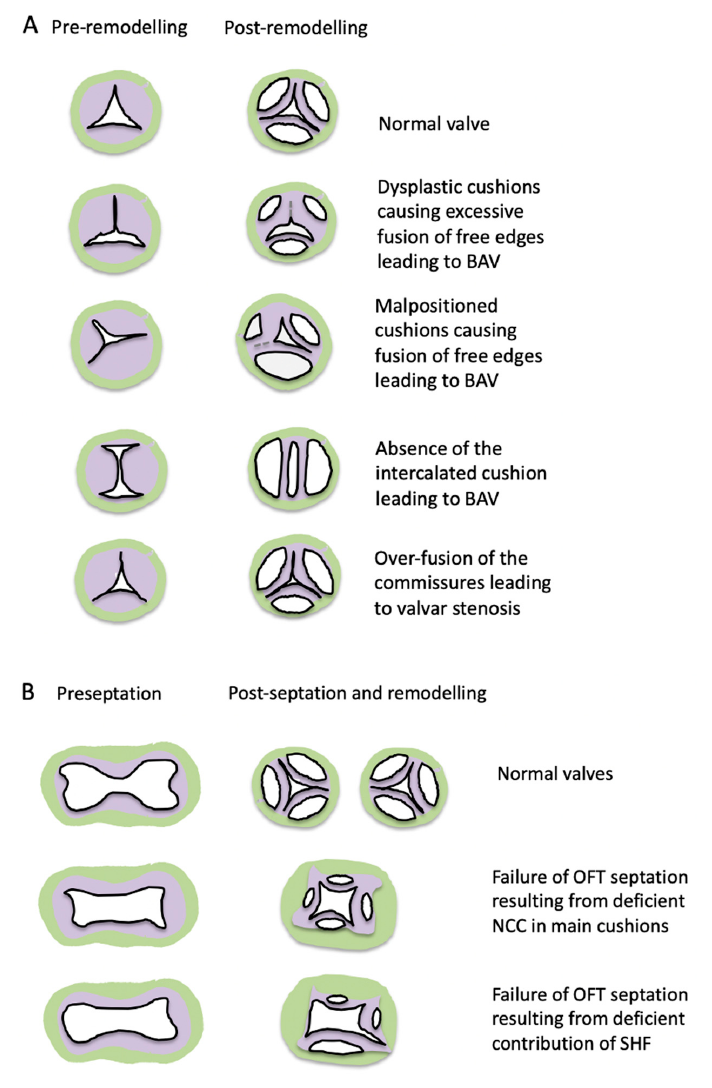
Figure 6. Possible mechanisms underlying THE bicuspid aortic valve BAV. ( A ) Cartoon illustrating several possible mechanisms underlying BAV in the situation of outflow tract septation. These can result in different numbers of sinuses and raphes and can occur early in development (as shown) or later in development as a consequence of pathological processes. Valvar stenosis could also be caused by over fusion of the cushions, at the commissures. ( B ) Cartoon illustrating possible valve outcomes when outflow septation fails. In the case of the proposed situation where the SHF is deficient, the numbers of leaflets can be highly variable, possibly depending on the extent of deficiency.